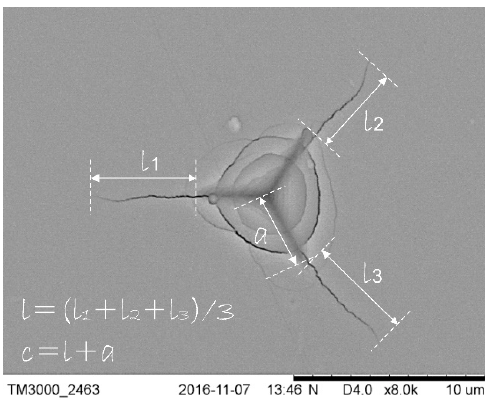
Figure2. Illustrationsofthemeasurementmethodoffracturetoughnessforallinvestigatedindentations. Figure 2. Illustrations of the measurement method of fracture toughness for all investigated indentations.